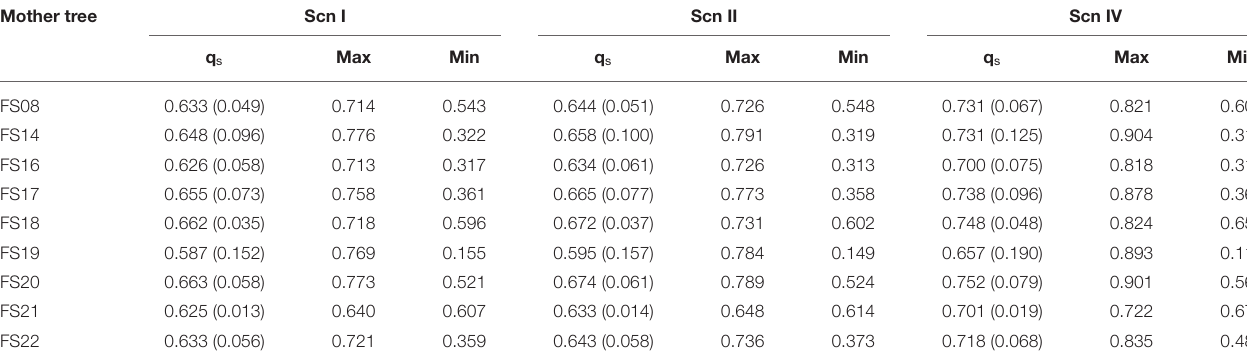
TABLE 2 | STRUCTURE’s q s and INTROGRESS hybrid index estimates for the progenies of the open-pollinated hybrid families under each scenario. Mother tree